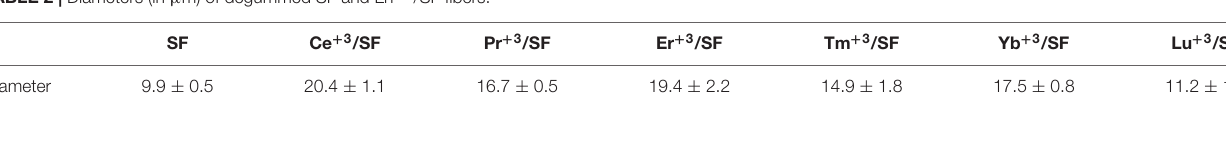
TABLE 2 | Diameters (in µ m) of degummed SF and Ln + 3 /SF fibers. SF Ce + 3 /SF Pr + 3 /SF